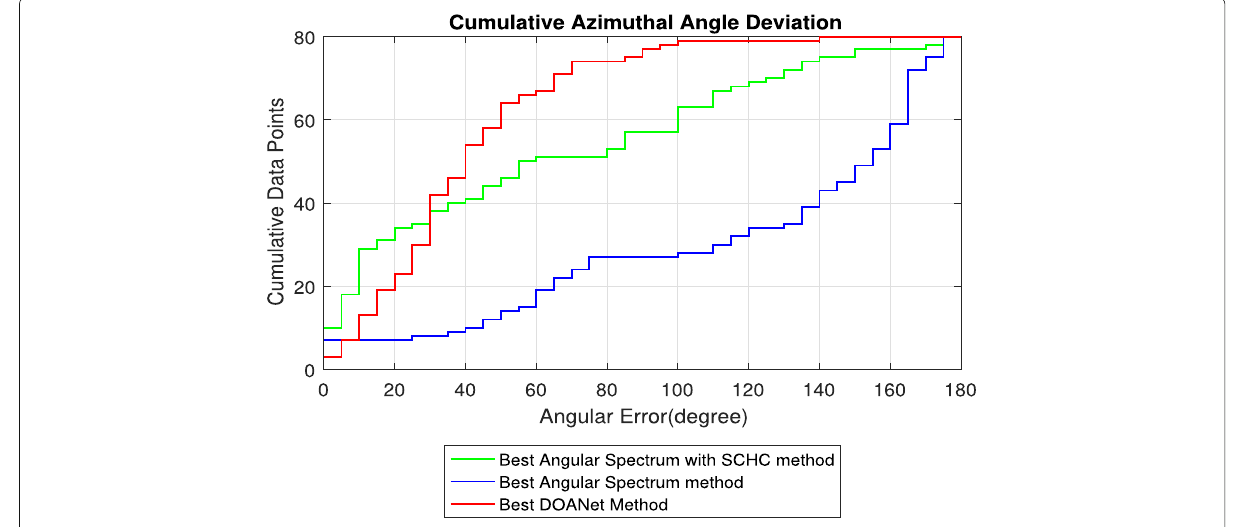
Fig. 11 AUCs for cumulative in-flight azimuth angle deviation